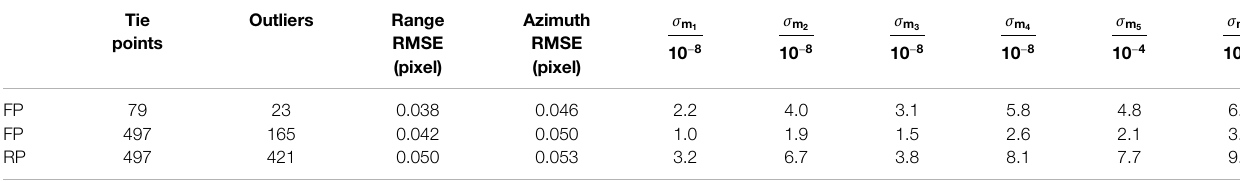
TABLE 1 | The comparison of fi tting af fi ne matrix with feature and regular tie points. Tie points